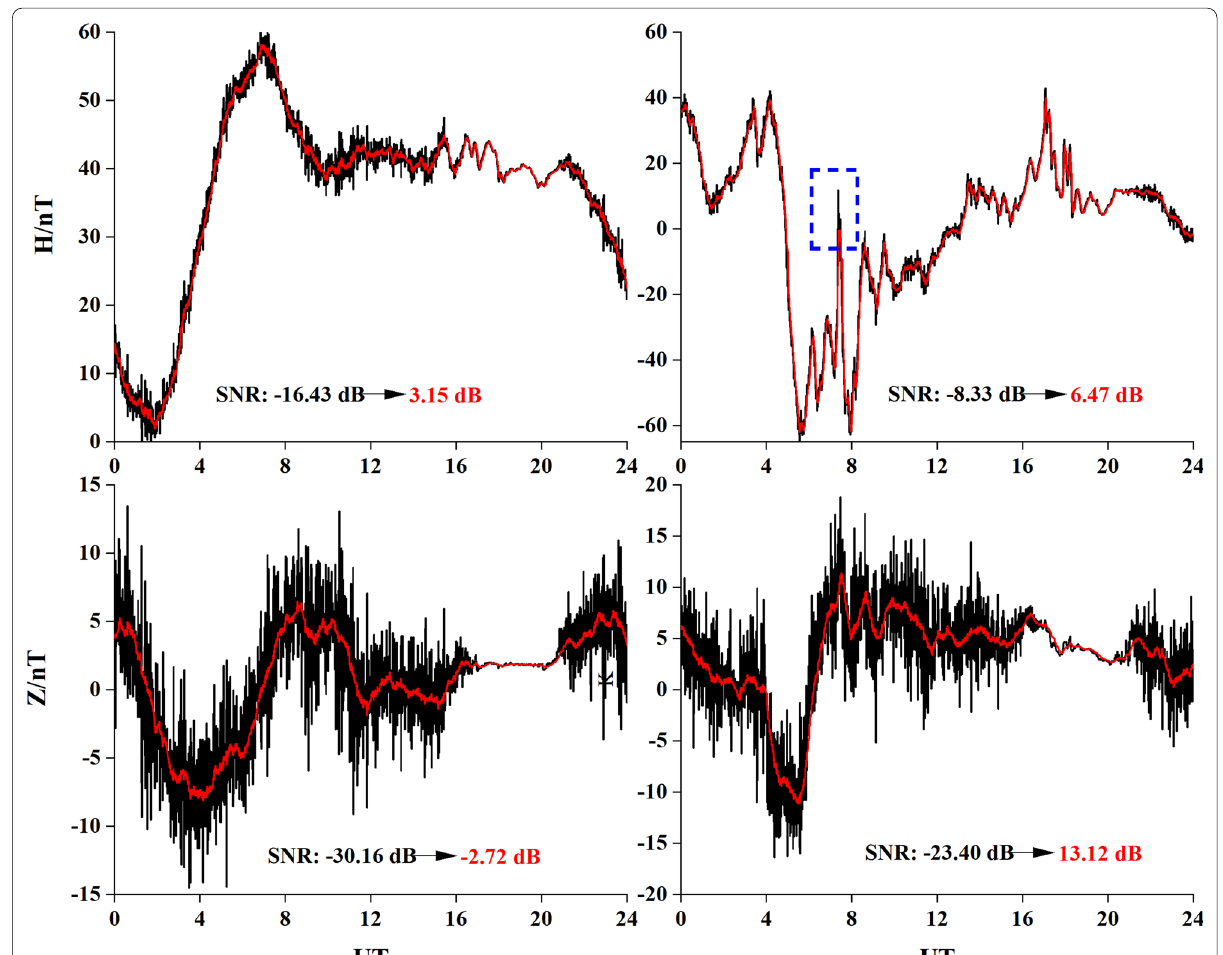
Fig. 4 Horizontal (top) and vertical (bottom) component of geomagnetic data on May 5 (left), and May 14 (right), 2019 collected at BJI. Black and red lines represent the raw data and the processed data with the adaptive Kalman filter,